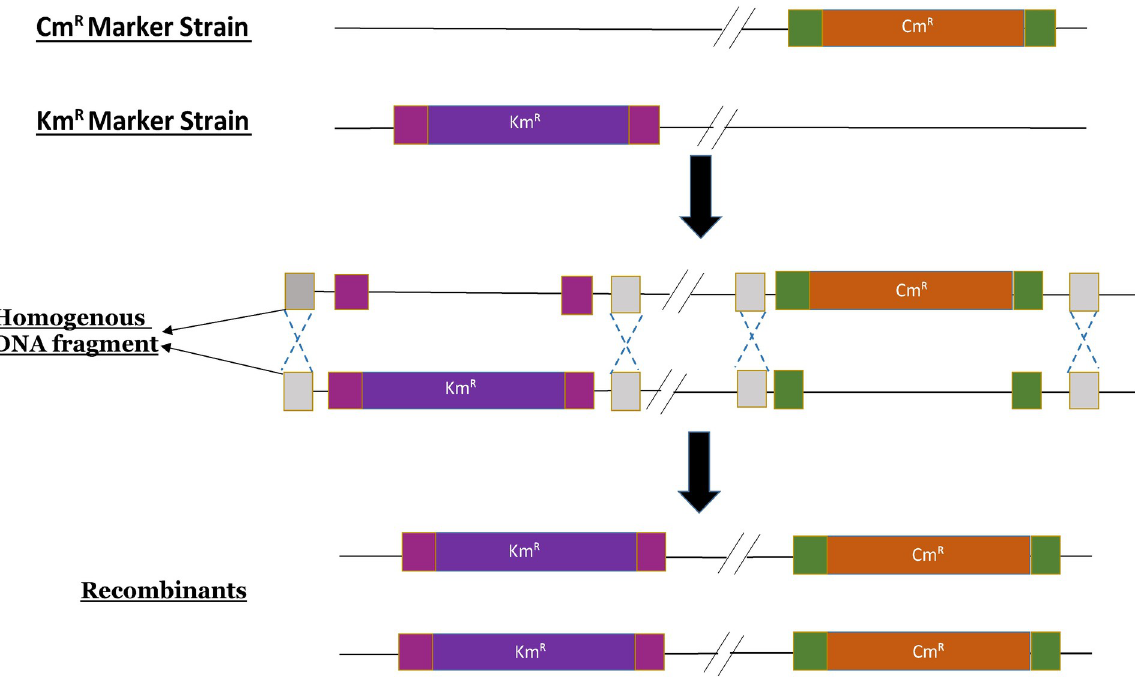
Fig 2. Diagram showing possible homologous recombination that takes place between the two marker strains.